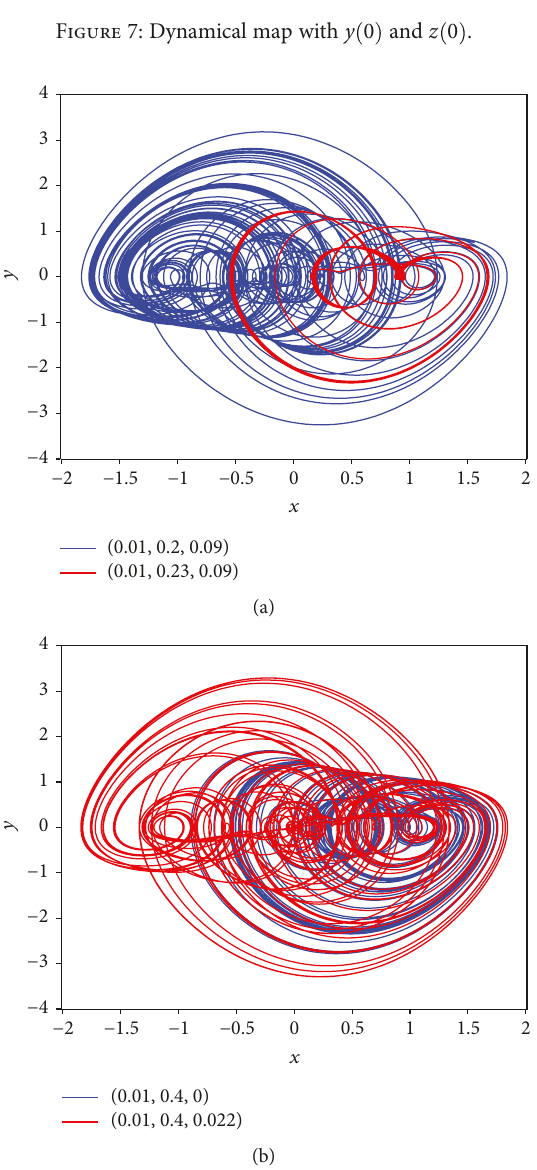
Figure 6: (a, b) Bifurcation diagram and (c) Lyapunov exponent spectrum versus x 0 . Figure 8: Attractors on x - y plane with di ff erent initial conditions.